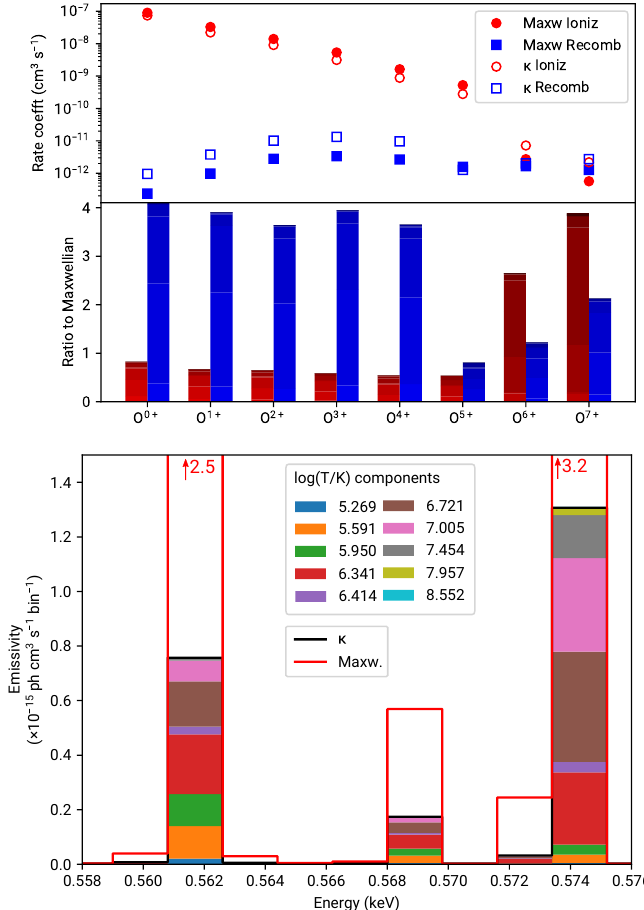
Figure 2. Ionization and recombination rate coefficients of oxygen in a kT = 0.2 keV, κ = 2.0 plasma. Top : The total rate coefficients for the κ and Maxwellian case. Middle : The ratio of the κ = 2.0 ionization (red) and recombination (blue) rates to their Maxwellian equivalent. The different shades represents the contribution of each Maxwellian component from the decomposition method of [18]. Bottom : The resulting emission in the O 6 + He- α triplet. The components of the Maxwellian decomposition are again shown in different colors. Note that the Maxwellian total emissivity, marked with the red line, is larger due to the charge state distribution having more O 6 + in the Maxwellian case.